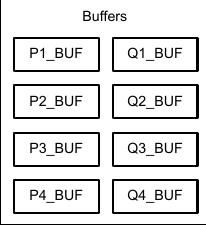
Figure 7. Buffers to store the pixel